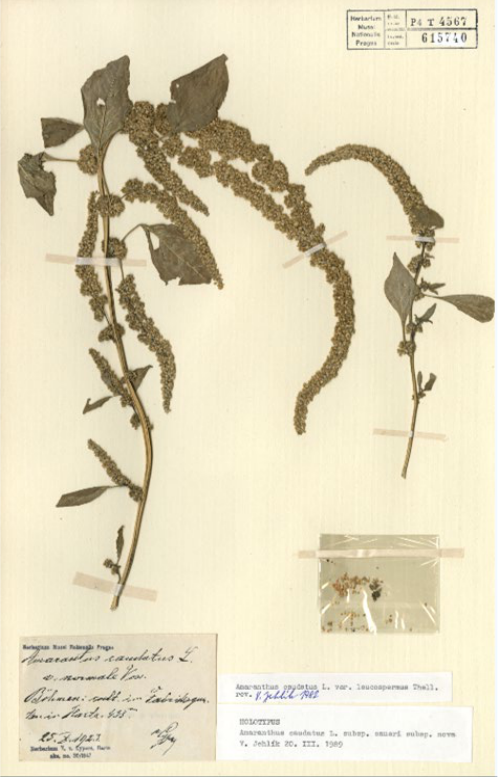
Figure 1. Holotype of the name Amaranthus caudatus subsp. saueri